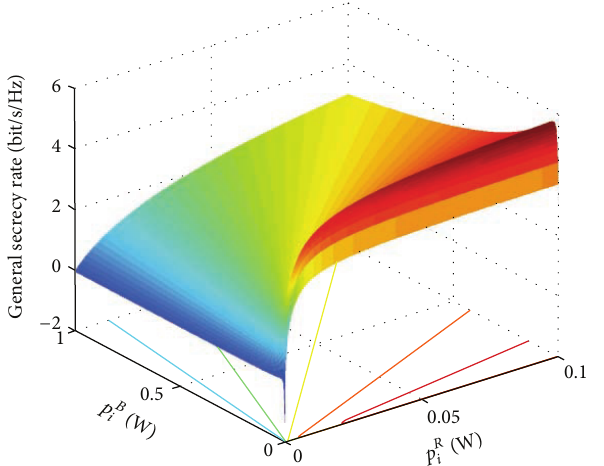
Figure 3: General secrecy rate as a function of relay power and jamming power.